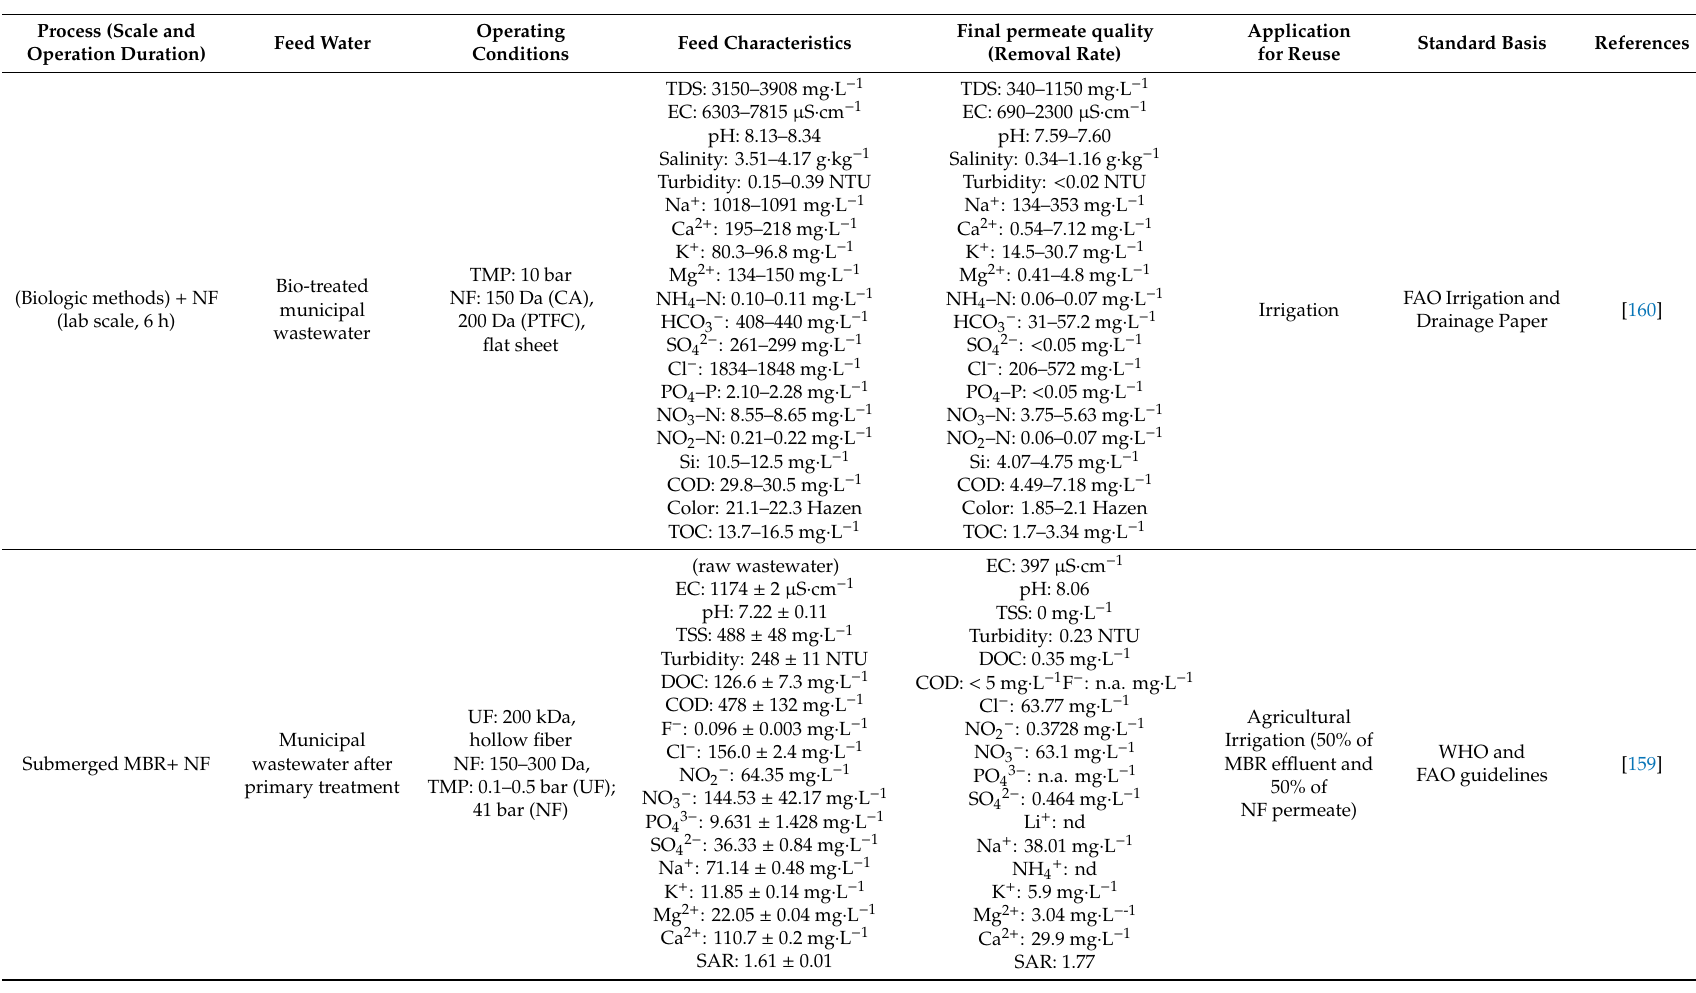
Table 9. Nanofiltration (NF) / reverse osmosis (RO) / forward osmosis (FO) coupled with pretreatment processes for wastewater reuse applications. Process (Scale and Operation